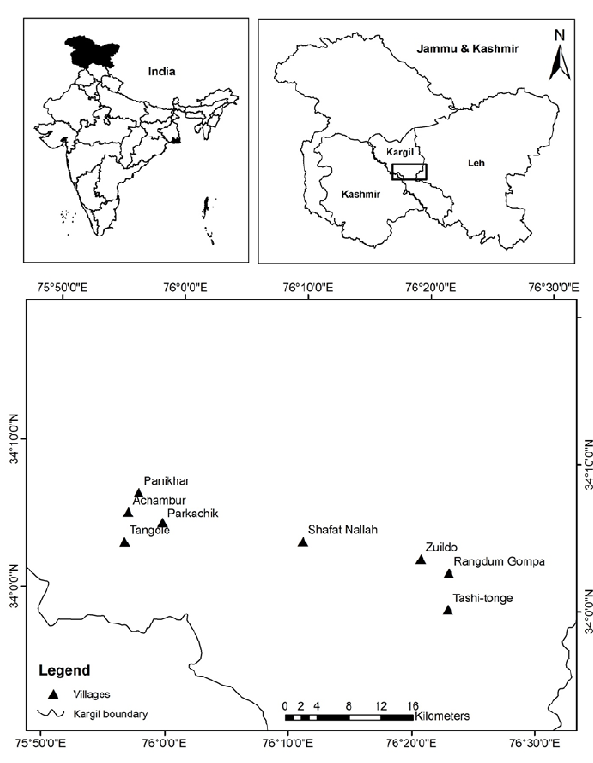
Fig. 1. Outline map of the